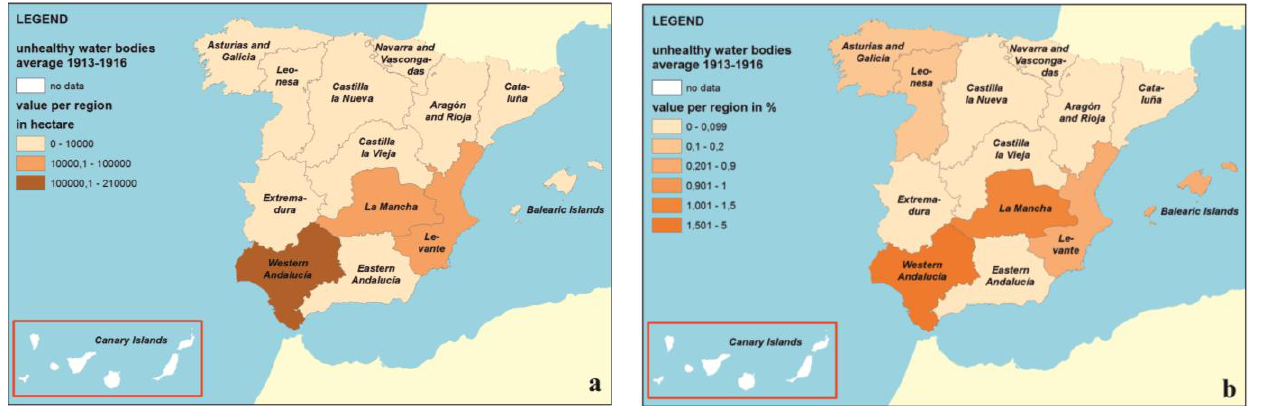
Figure 3. ( a ) Geographic distribution of the total surface occupied by unhealthy water bodies in each region. ( b ) Percentage of the surface occupied by unhealthy water bodies in each